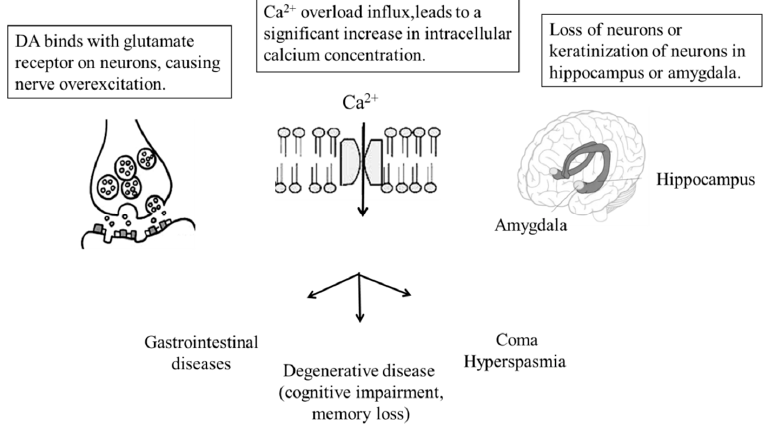
Figure 1. The mechanism of excitatory neurotoxicity of DA.